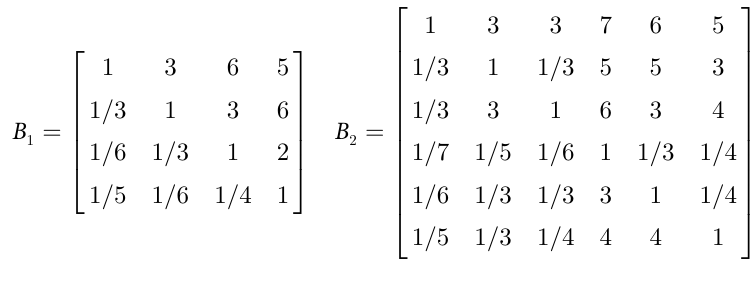
where b ( j = 1,2, . . . , n ) is obtained by the j column operation of A and R , and represents the j membership degree of the rated object to the fuzzy subset of V Case analysis The square root method and GA were used to solve the weights of the elements in the follow- ing two judgment matrices respectively. The results were showed in Table 1.